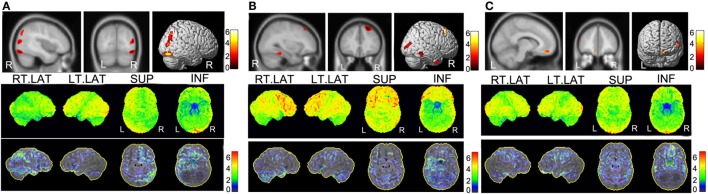
PET imaging results of three cases with favorable outcome but were discordant between SPM and 3D-SSP. In each panel, the upper part is the SPM-PET result (P < 0.001, voxel size 50 corrected), and the lower part is the SD-SSP-PET result with Z-score. (A) Case 5, the PEZ was localized at the right temporal lobe and underwent right anterior temporal lobe lesion resection. 3D-SSP showed a CS result with the PEZ of the right temporal lobe hypometabolism; however, SPM results were focused on the right occipital lobe hypometabolism. Considering the postsurgical pathology, the SPM result seemed untrustworthy. (B) Case 13, the right temporal and frontal lobes were considered to be PEZ. Overlapping hypometabolism regions were detected by SPM. In contrast, 3D-SSP only detected the epileptic focus in the right temporal lobe. Even though a very small metabolism was also found in the right frontal lobe by 3D-SSP, it is too small to account it as an epileptic focus, given the similar metabolism in the same position of the contralateral hemisphere. (C) Case 7, the PEZ was situated at the left temporal lobe and was confirmed by the postsurgical pathology. However, both 3D-SSP and SPM detected the hypometabolism of the left prefrontal lobe, not the temporal lobe.